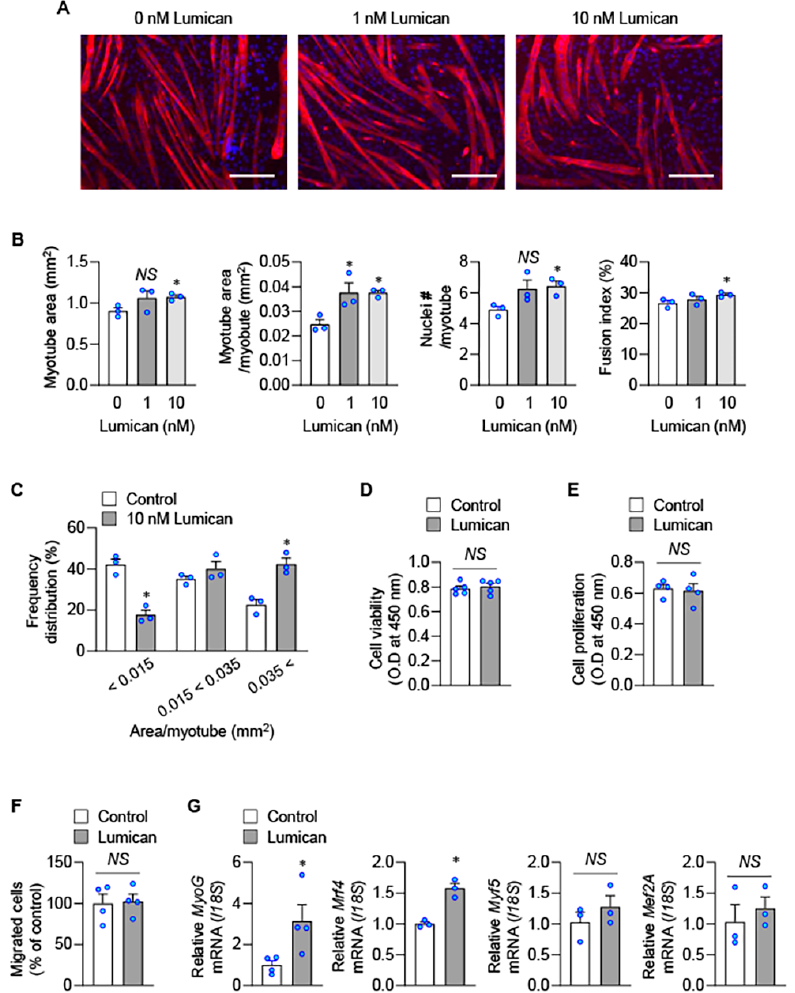
Figure 2. Lumican-mediated myoblast differentiation. ( A – C ) C2C12 cells were differentiated with indicated lumican concentrations for 3 days. Myotubes were stained with the anti-myosin heavy chain antibody ( A ), and morphological parameters of myotubes, such as total myotube area, myotube area per myotube, nuclei # per myotube, and fusion index, were quantified ( B ). Frequency distribution of myotubes was also determined ( C ). ( D , E ) C2C12 cells were treated with or without 10 nM lumican for 24 h, and cell viability ( D ) and proliferation ( E ) were examined using Cell counting kit-8 and Cell Proliferation ELISA, respectively. ( F ) Migration of C2C12 cells was examined using a type IV collagen-coated filter with 10 nM lumican. Migrated cells were quantitated. ( G ) C2C12 cells were incubated with or without 10 nM lumican for 24 h, and real-time PCR was performed. Each bar represents the mean ± standard error of the mean (SEM). Scale bars: 200 μ m. * p < 0.05 vs. the untreated control. NS , not significant.